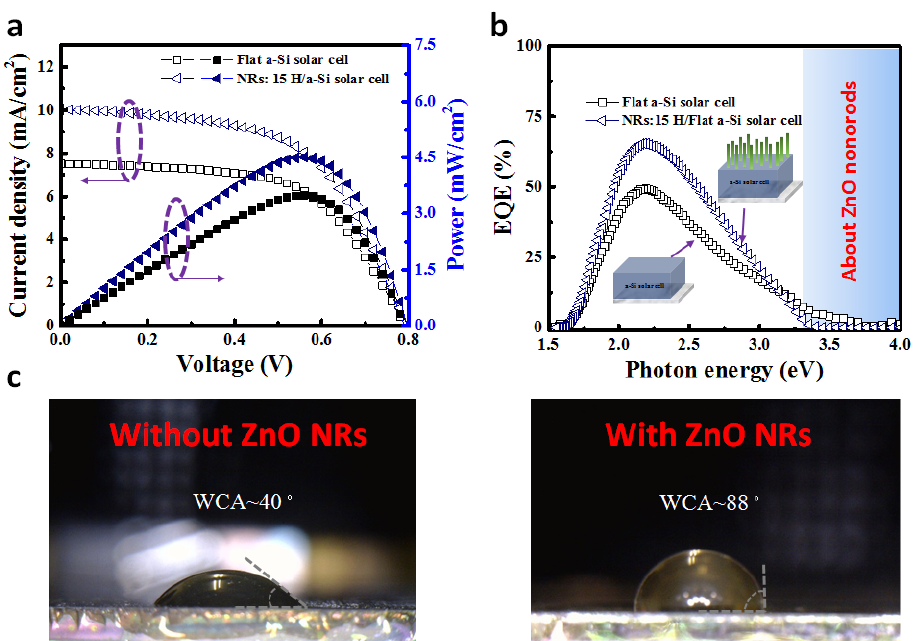
Figure 4. ( a ) J-V curves under AM1.5 G (100 mW/cm 2 ). ( b ) EQE spectrum of the a-Si:H thin-film bare photovoltaic cell and cell with ZnO nanorods. ( c ) WCAs of the a-Si:H thin-film bare photovoltaic cell and a-Si:H thin-film photovoltaic cell with ZnO NRs on the surface.